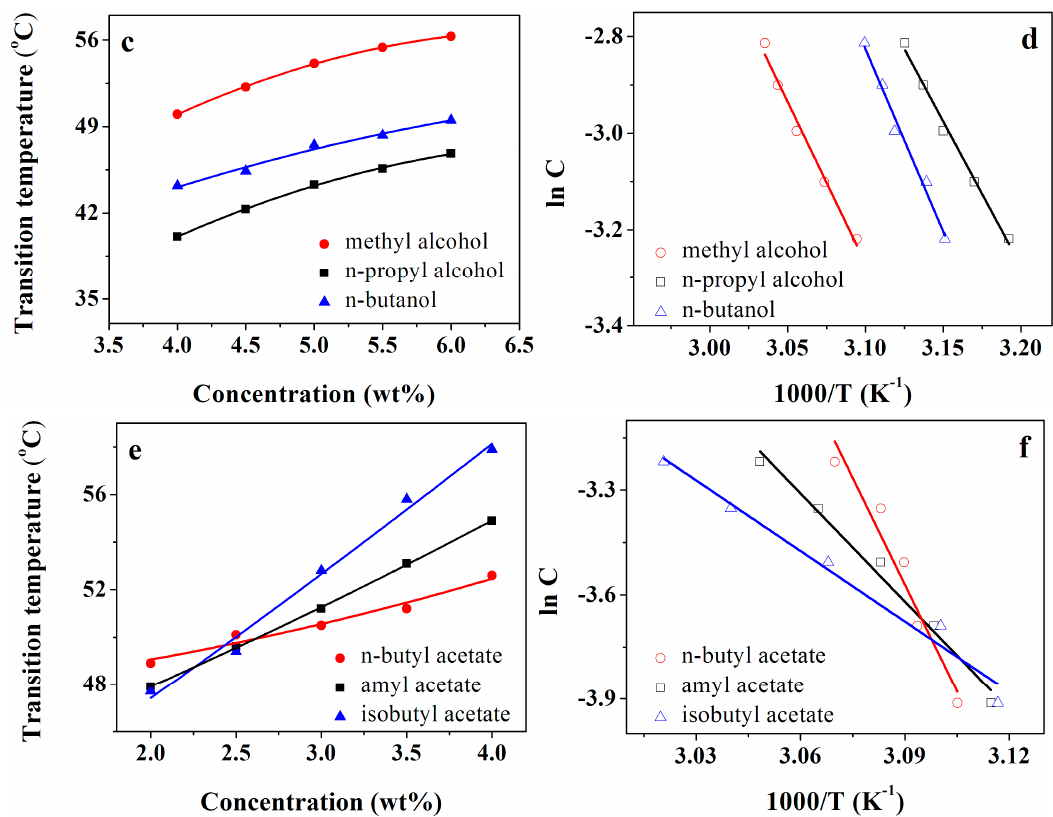
Figure 1. The gel–sol phase-change temperatures ( T GS ) as a function of concentration of compound 4 ( a , c , e ) and van ’t Hoff plots of compound 4 ( b , d , f ) in certain organic solvents. Table 2. The Kamlet–Taft parameters and enthalpy values of compound 4 in some